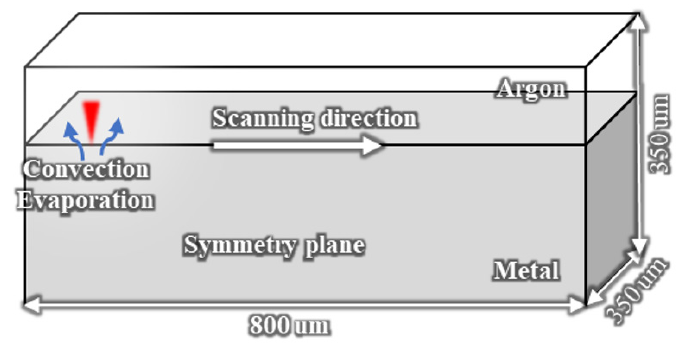
Figure 2. Schematic of boundary condition and computational domain for laser scanning simula- tion.